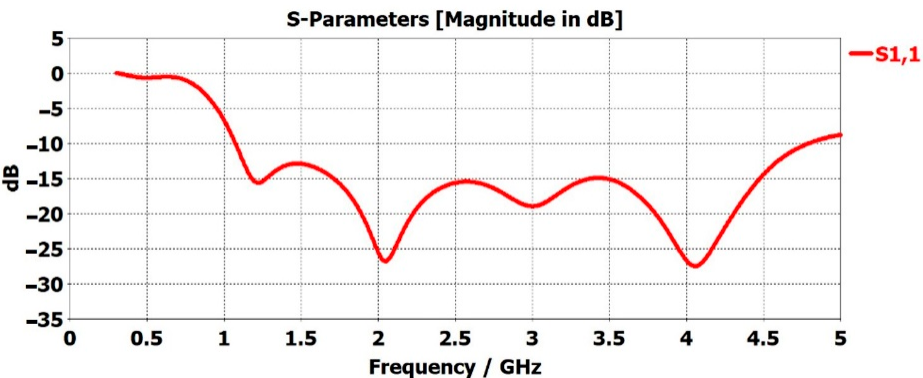
Figure 5. S-parameter, S 11 , of stepped monopole antenna in free space.